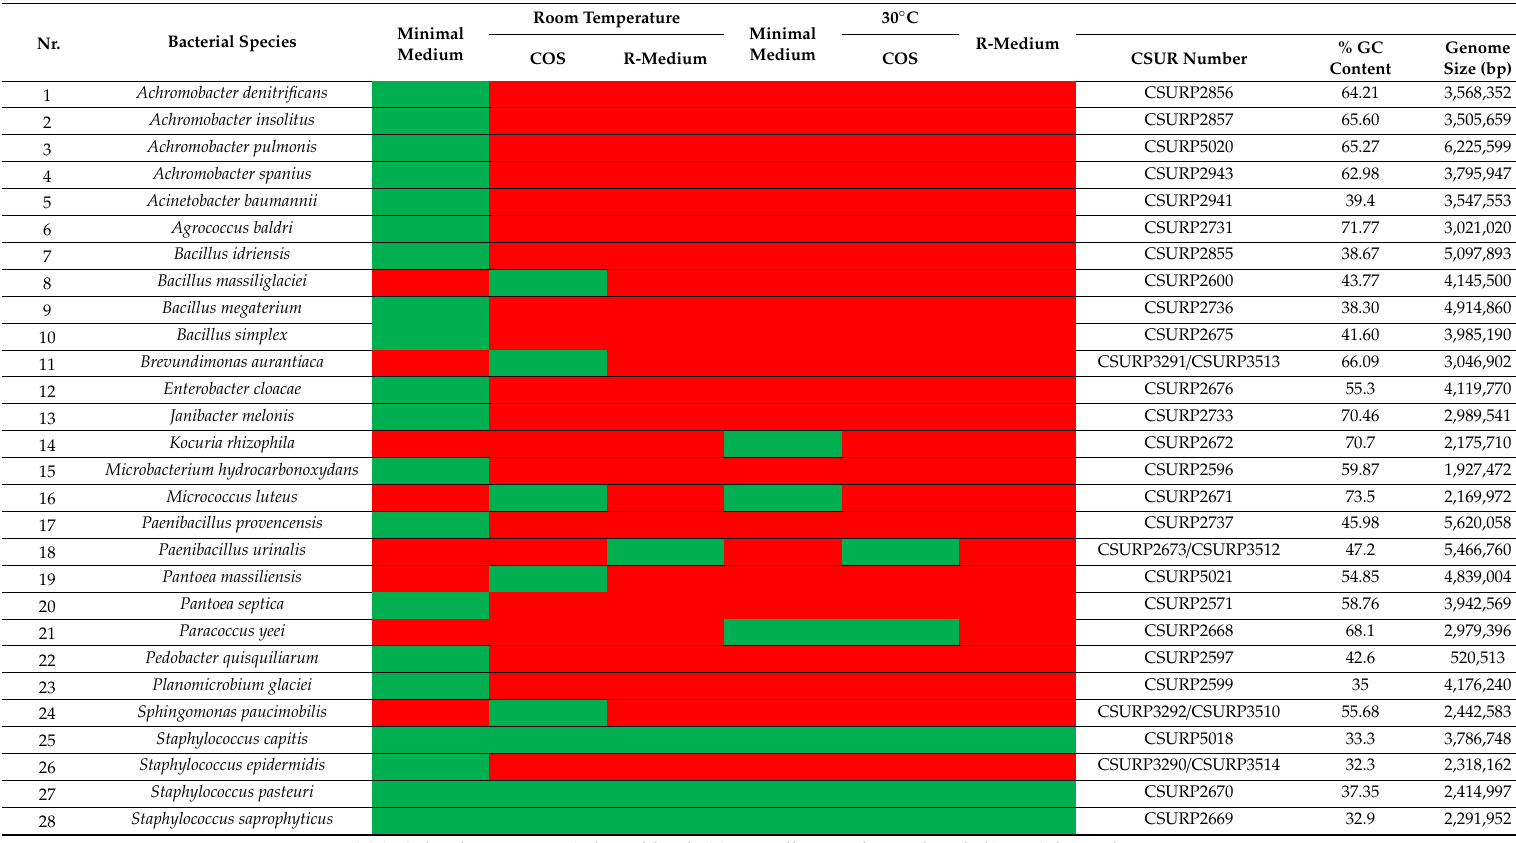
Table 1. Microarray showing bacterial species according to culture media and conditions used for their isolation (atmosphere, pH and salinity included). Green = positive culture; Red = negative culture. Cos: Columbia with 5% sheep blood agar.